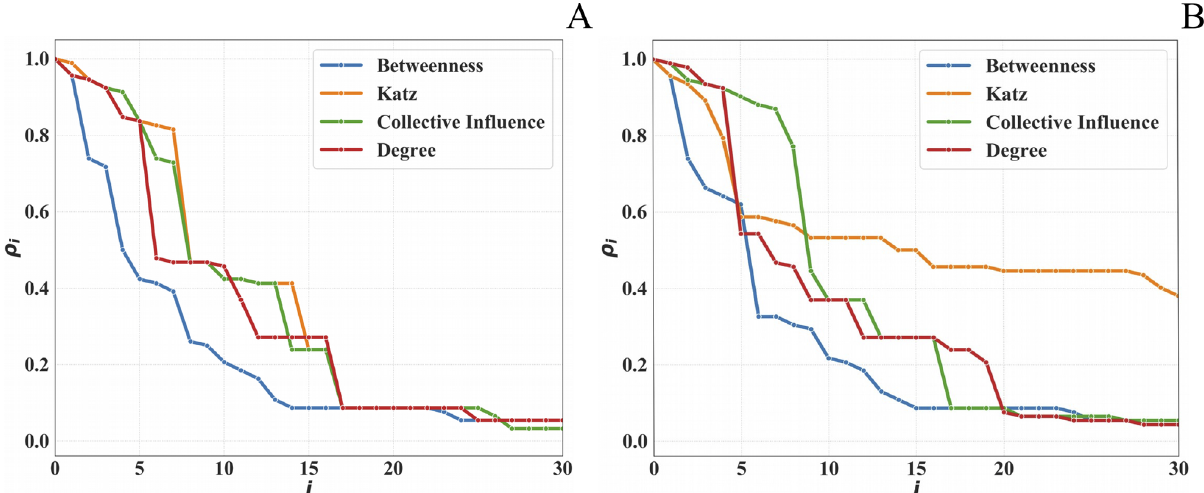
Fig 2. First 30 iterations of the sequential node removal strategy, Meetings dataset. A: Unweighted Graph. B: Weighted Graph.